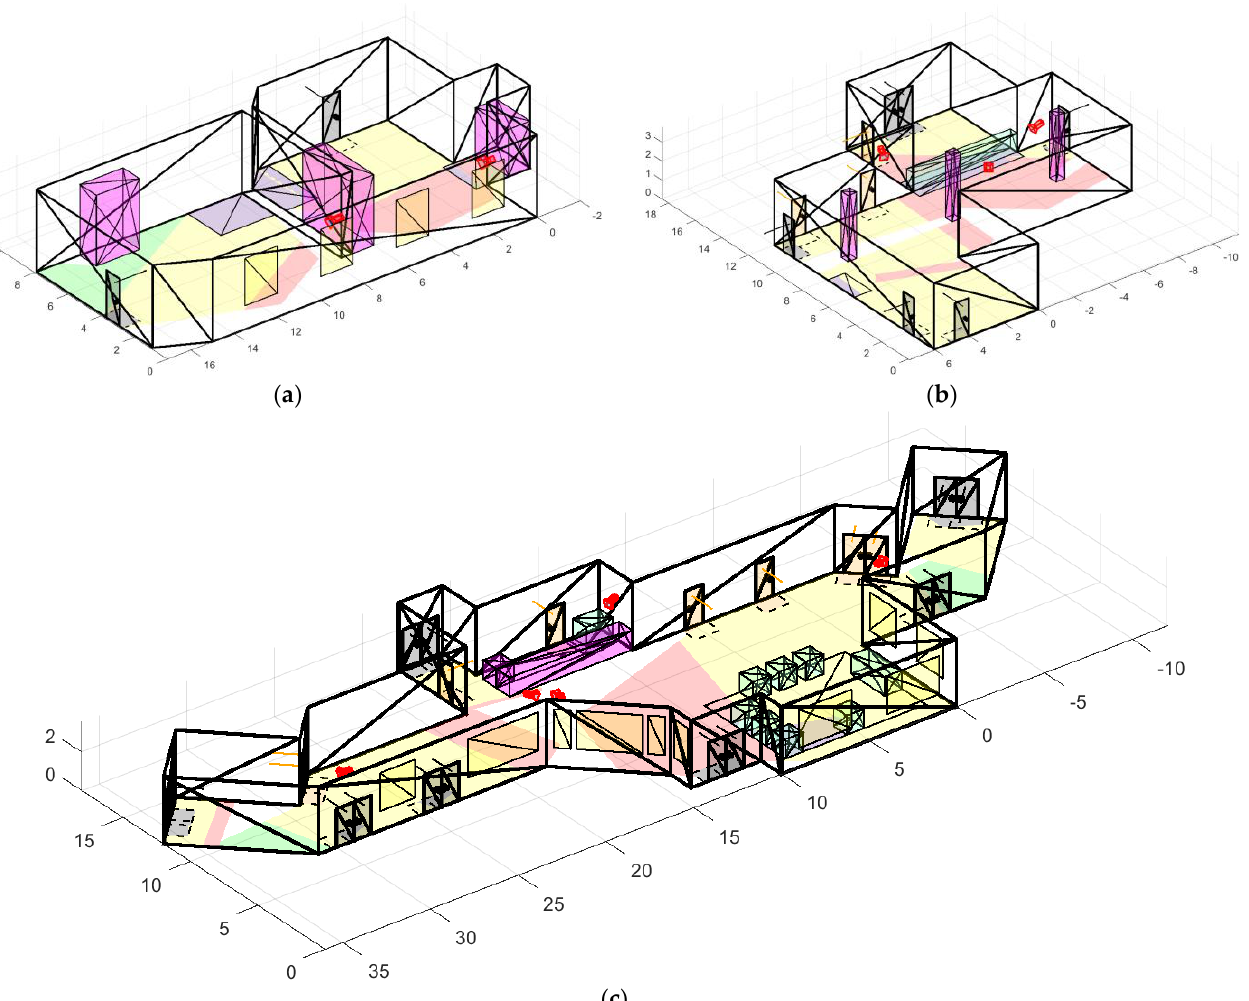
Figure 17. Found solutions for rooms of varying complexity: ( a ) simple case; ( b ) medium case; and ( c ) hard case.